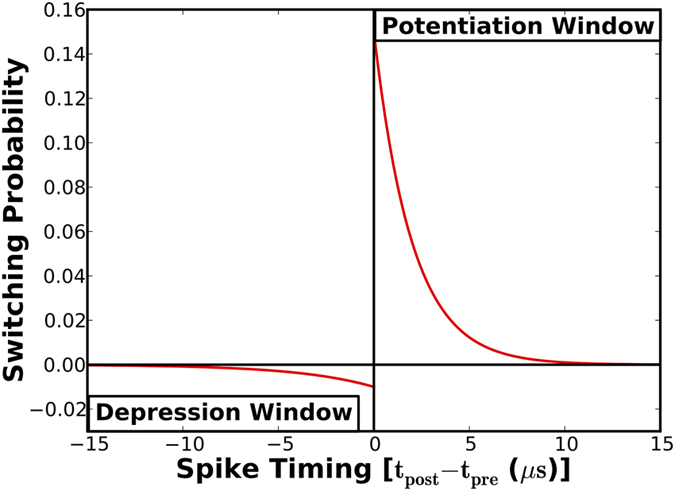
Stochastic STDP dynamics of a one-bit synapse, wherein the probability of potentiation and depression is exponentially related to the difference in the spike times of a post-neuron (tpost) and pre-neuron (tpre).